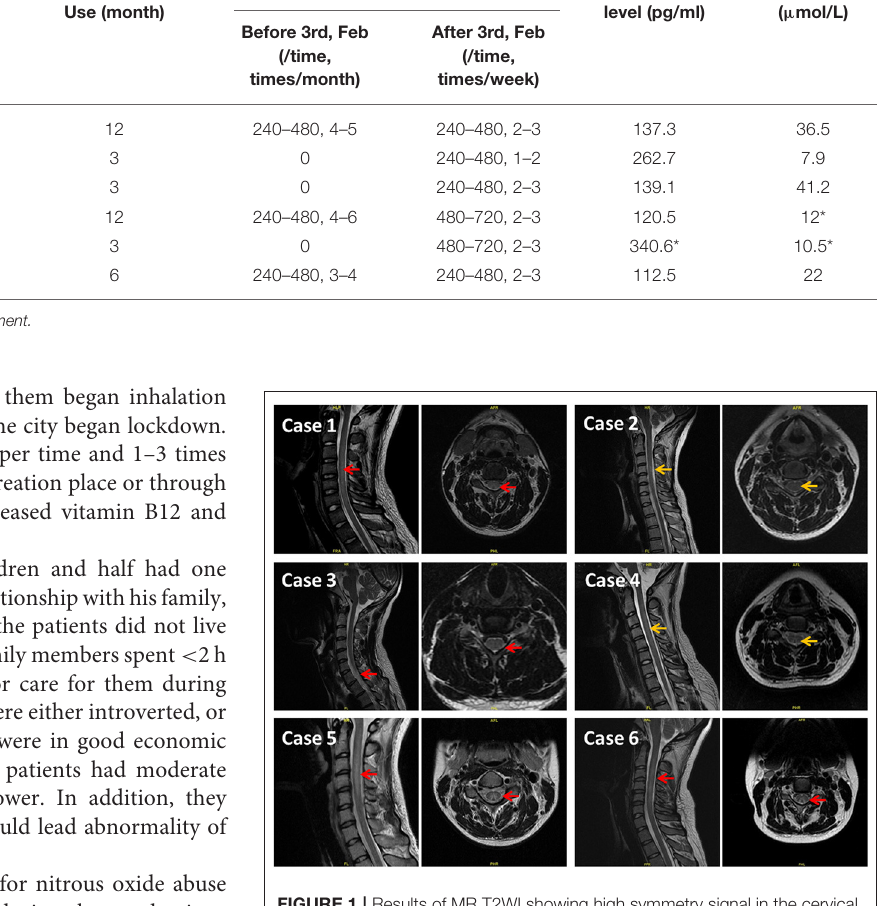
All were diagnosed with subacute combined degeneration of the spinal cord (SCD). The six patients had improved neurological outcomes after vitamin B12 and adenosine cobalamin therapies for 5–8 days and discharged. They were prescribed vitamin